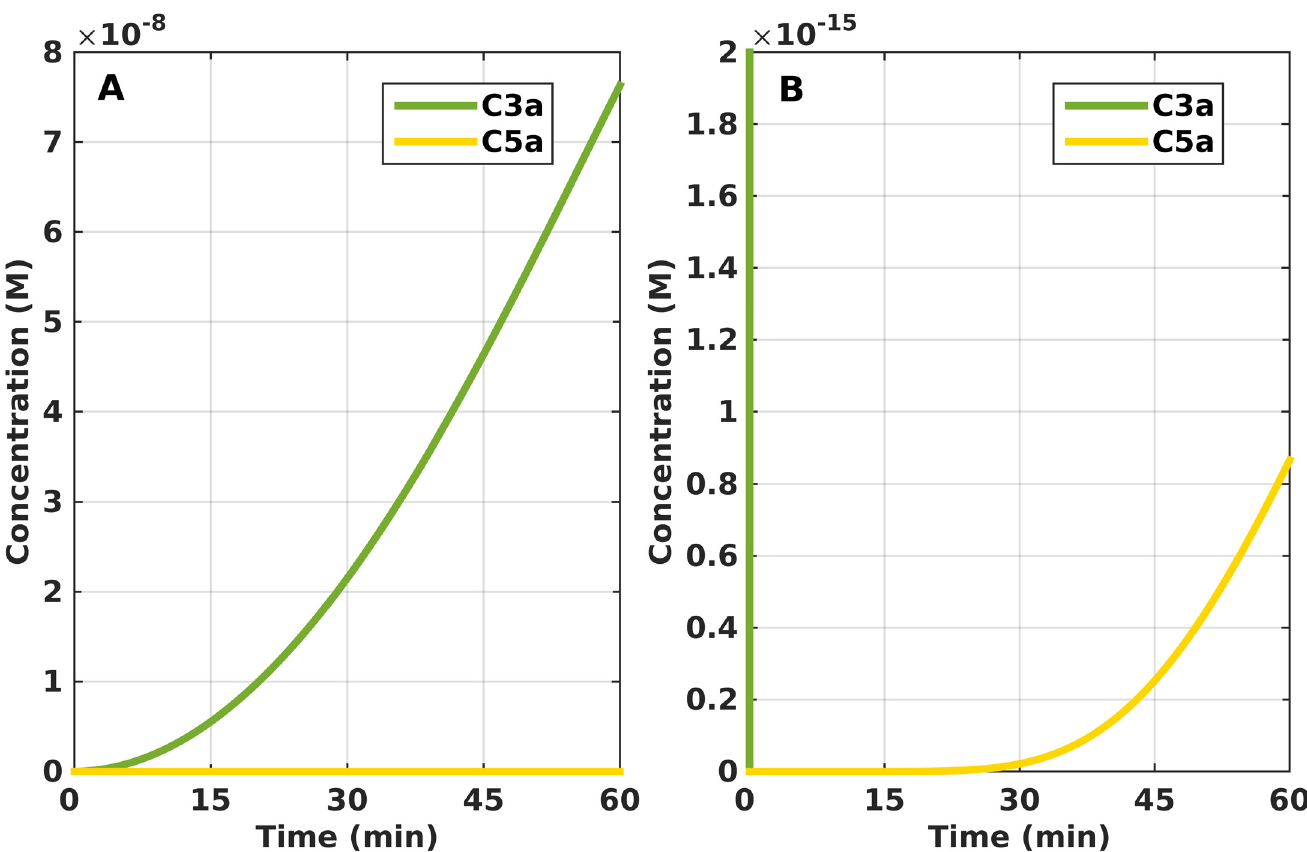
Fig 5. Time profile for the production of C3a and C5a. (A) The response generated for C3a shows a lag phase that is followed by an accelerated production phase. In 60 minutes, the amount of C3a produced is 10 8 times greater than that of C5a. (B) Zoom-in of panel (A) to show the time profile of C5a.